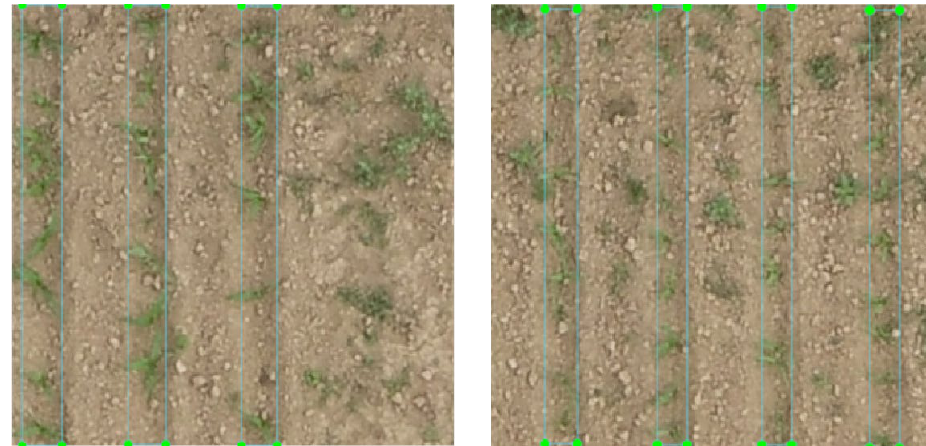
Figure 4. Labeling method of crop row dataset.